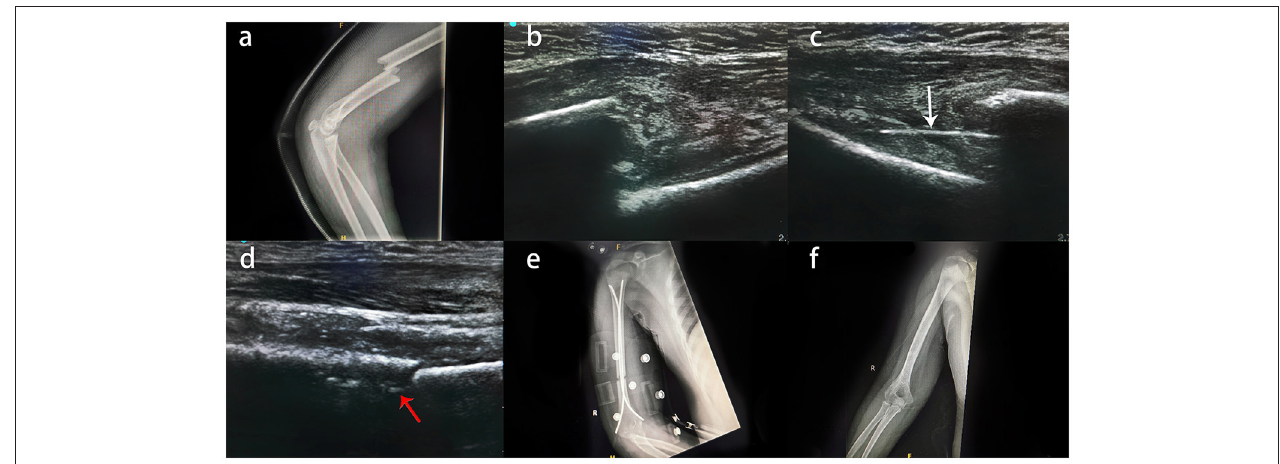
FIGURE 1 | Typical case of an 11-year-old boy with right humeral shaft fracture treated by US-guided closed reduction and ESIN fixation. (A) X-ray examination of the child after injury revealed a middle humeral shaft fracture. (B) Intraoperative US showed that there was no soft tissue or nerve incarceration at the fracture site, and closed reduction was possible. (C) ESIN just past the fracture (white arrow). (D) ESIN in the bone marrow cavity after closed reduction (red arrows); it was not detectable in every patient by US. (E) Reexamination by radiography on the first day after the operation. (F) Good fracture healing was observed by X-ray at the 12-month follow-up.